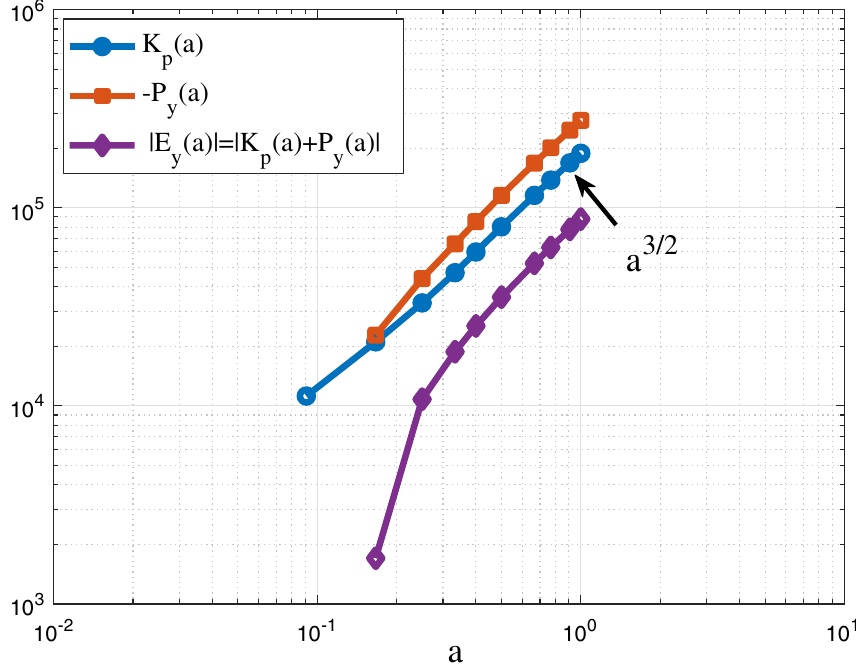
Figure 2. The time variation of kinetic and potential energies from N -body simulation. Both exhibit a power- law scaling with scale factor a , i.e. K p and P y